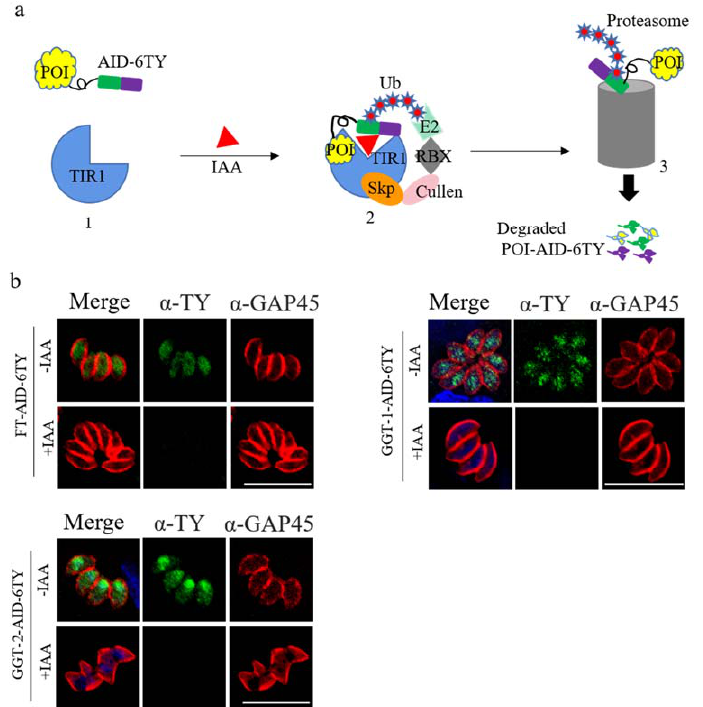
Figure 3. FT, GGT-1 and GGT-2 were degraded using the TIR1-AID system. ( a ) Model of target proteins degraded by TIR1-AID system. In this system, the receptor TIR1 is in inactive state in the absence of IAA, permi tt ing the fusion protein POI-AID-6TY to function in a normal way (1). After adding IAA, TIR1 can be activated, which prompts the formation of Skp-Cullen-F Box (2). The Box can identify and polyubiquitinate AID, leading to the proteasomal degradation for POI-AID-6TY (3). POI: protein of interest. ( b ) FT-AID-6TY, GGT-1-AID-6TY and GGT-2-AID-6TY could be e ff ec- tively degraded after adding IAA for 24 h. The degradation of FT, GGT-1 and GGT-2 was detected by IFA. Parasites were stained with anti-mouse ty monoclonal antibody (green) and anti-rabbit GRA45 (red). Nuclei were stained with DAPI (blue). Scare bars: 10 µM.